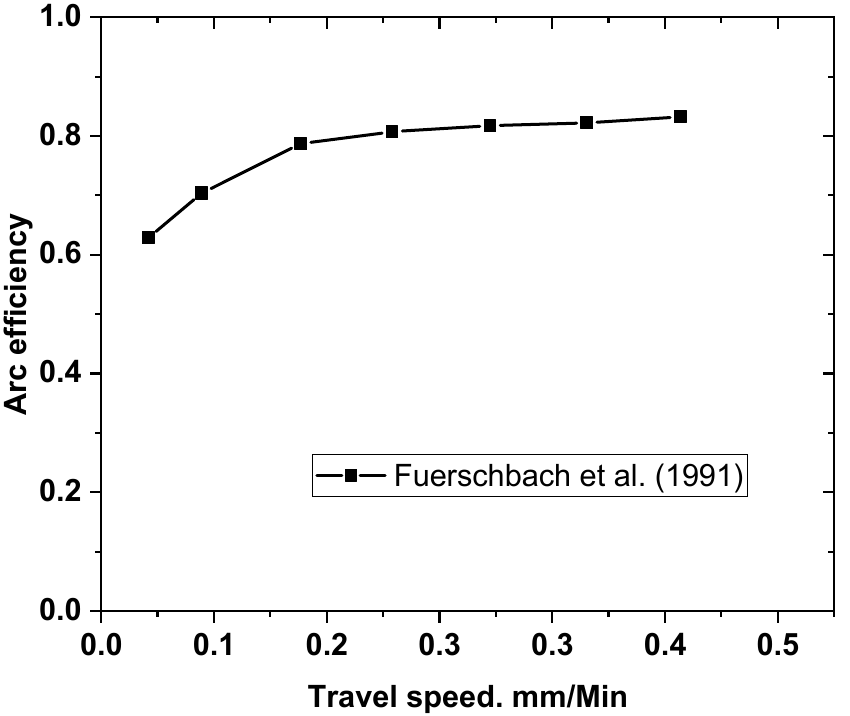
Figure 13. Welding arc efficiency as a function of speed (GTAW TIG welding) [38].